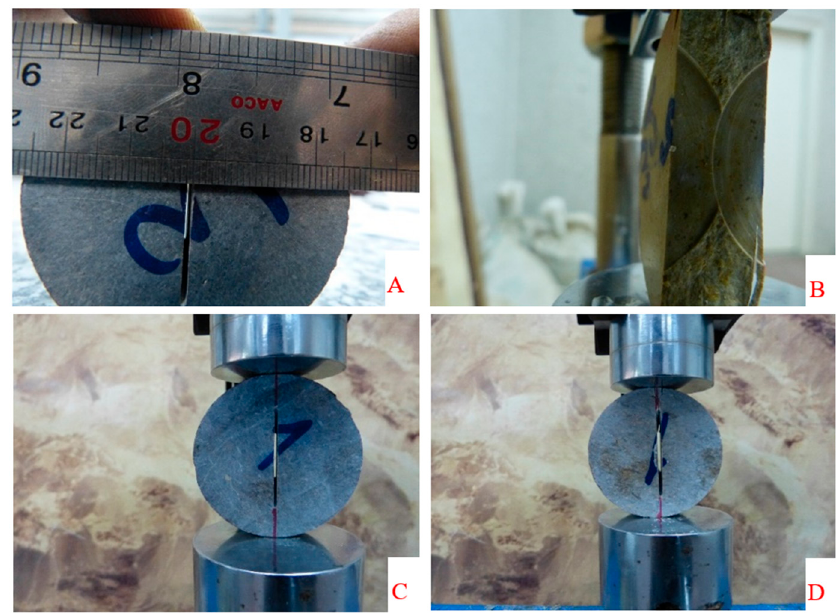
Figure 6. Wideness of the chevron crack ( A ), cross-section of the chevron notch ( B ), loading mode-I before failure ( C ), and loading mode-I after failure ( D ).